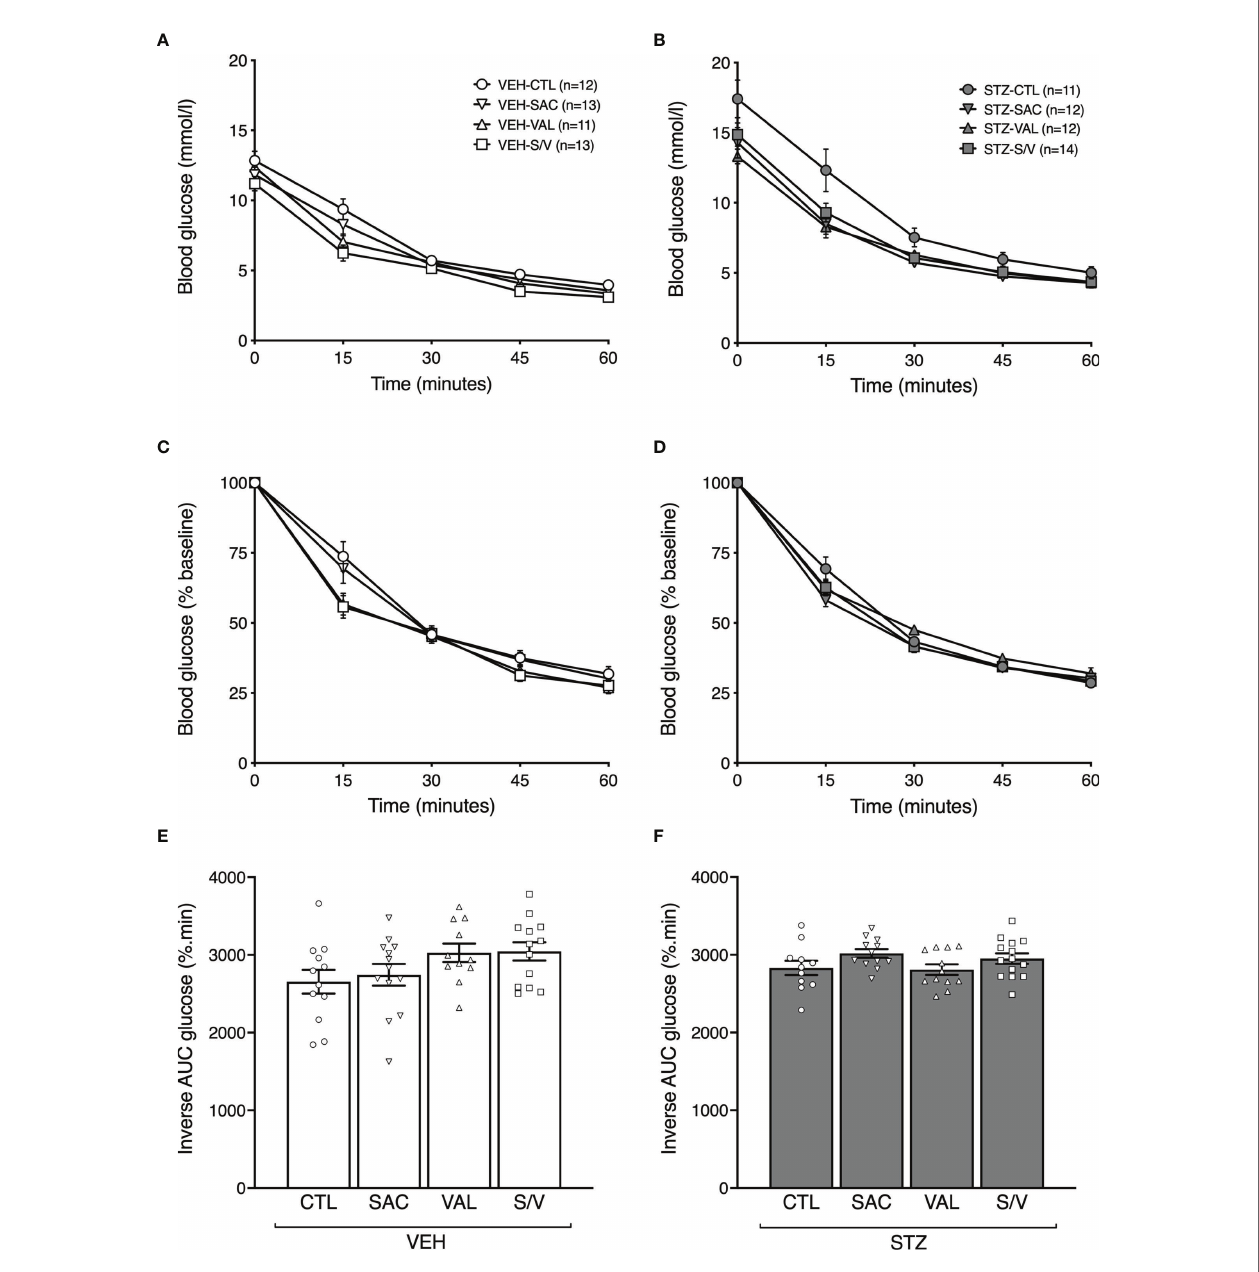
FIGURE 5 | Sacubitril, valsartan and sacubitril/valsartan do not alter insulin sensitivity in both obese and diabetic mice. Blood glucose levels, as absolute values (A, B) and as % of baseline (C, D) , during an intraperitoneal insulin tolerance test in high fat-fed mice injected with vehicle ( A, C ; VEH) or streptozotocin ( B, D ; STZ) and treated for 8 weeks with control (circles, CTL), sacubitril (inverted triangles, SAC), valsartan (triangles, VAL) or sacubitril/valsartan (squares, S/V). Inverse area under the % of baseline glucose curve accounting for adjustment for glucose baseline in VEH (E) - or STZ (F) -injected mice treated for 8 weeks with CTL, SAC, VAL or S/V.